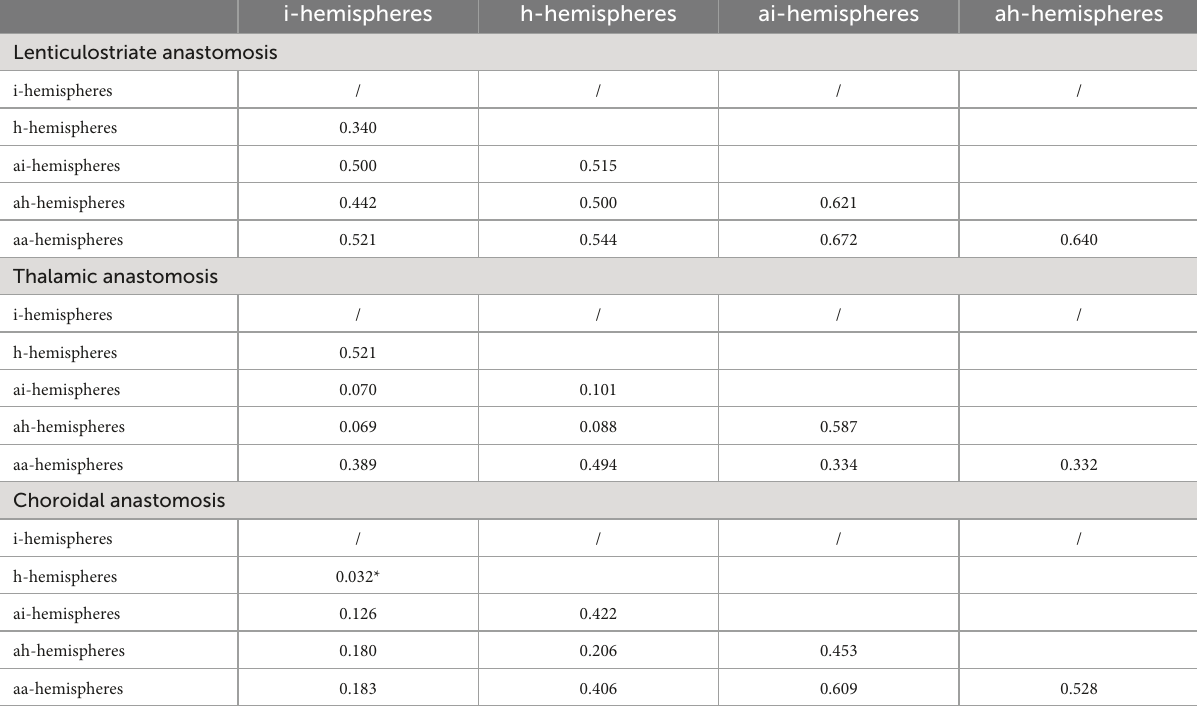
TABLE 2 Comparison of three types of collateral feature in different